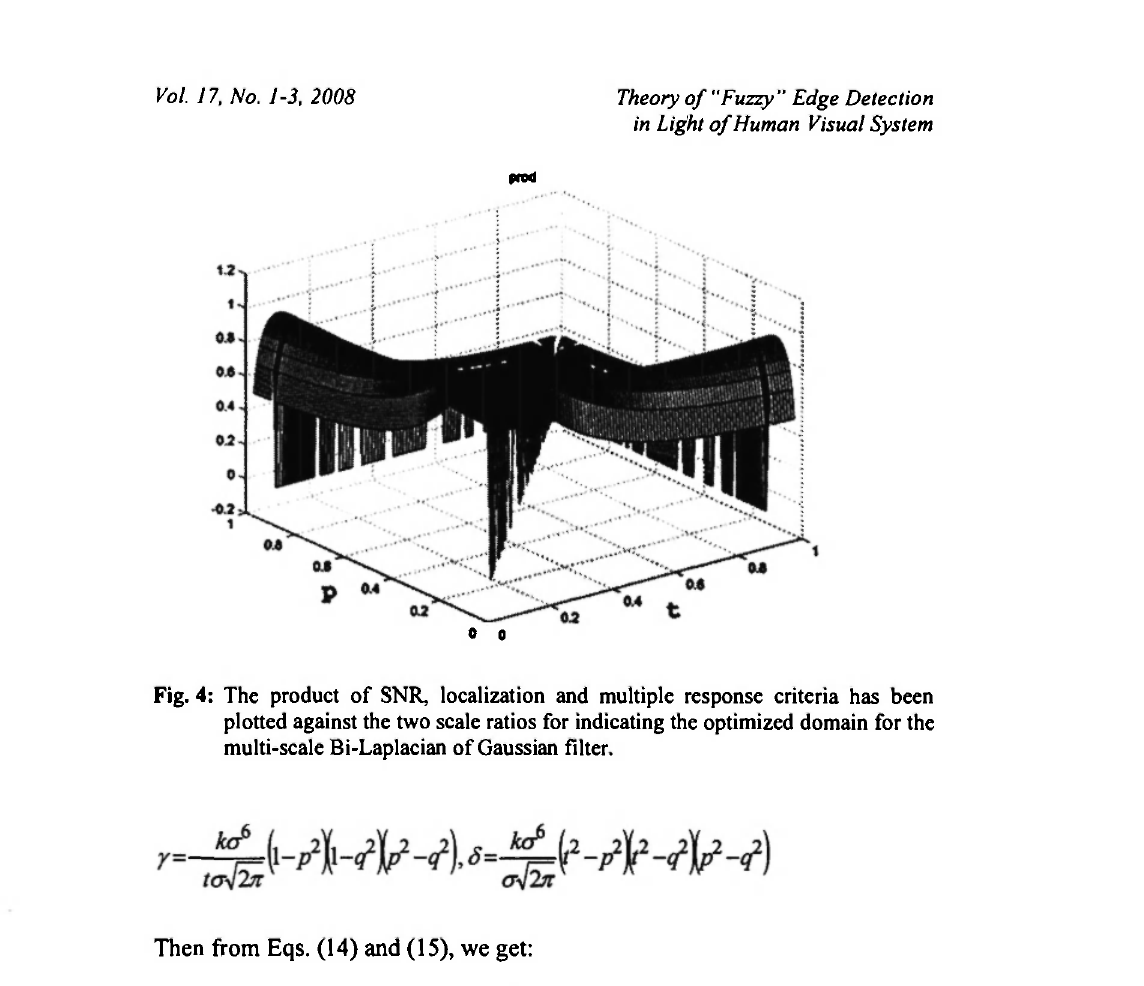
Fig. 4: The product of SNR, localization and multiple response criteria has been plotted against the two scale ratios for indicating the optimized domain for the multi-scale Bi-Laplacian of Gaussian